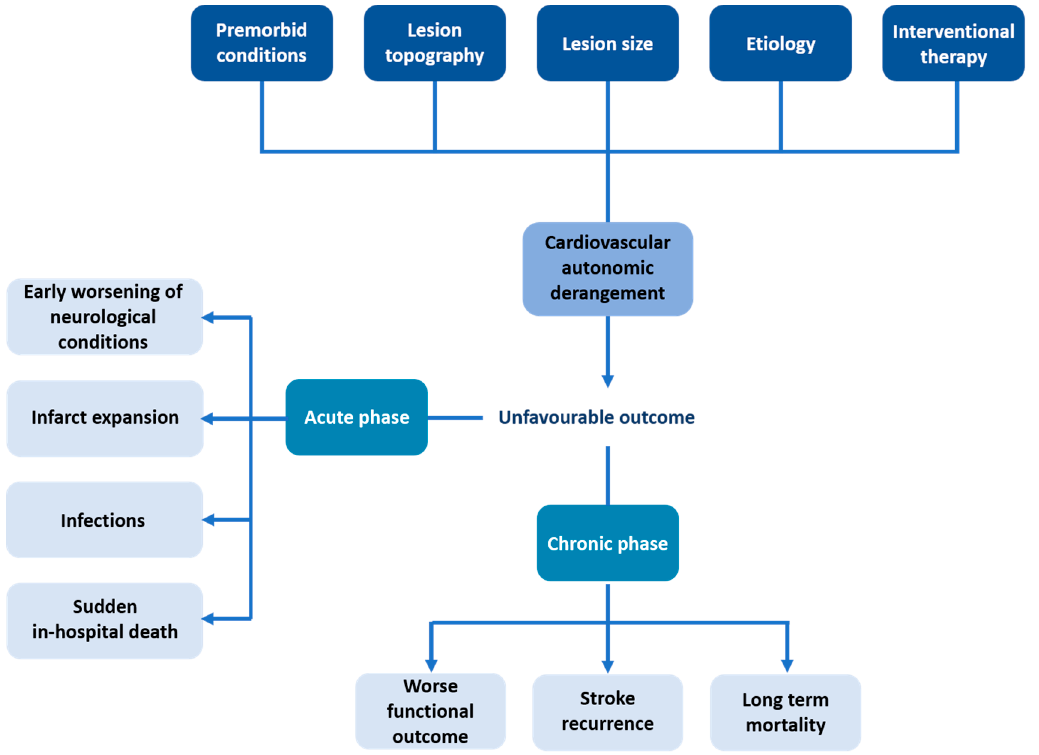
Figure 2. Cardiovascular autonomic derangement as a consequence of stroke and unfavorable outcomes in acute and chronic phase.